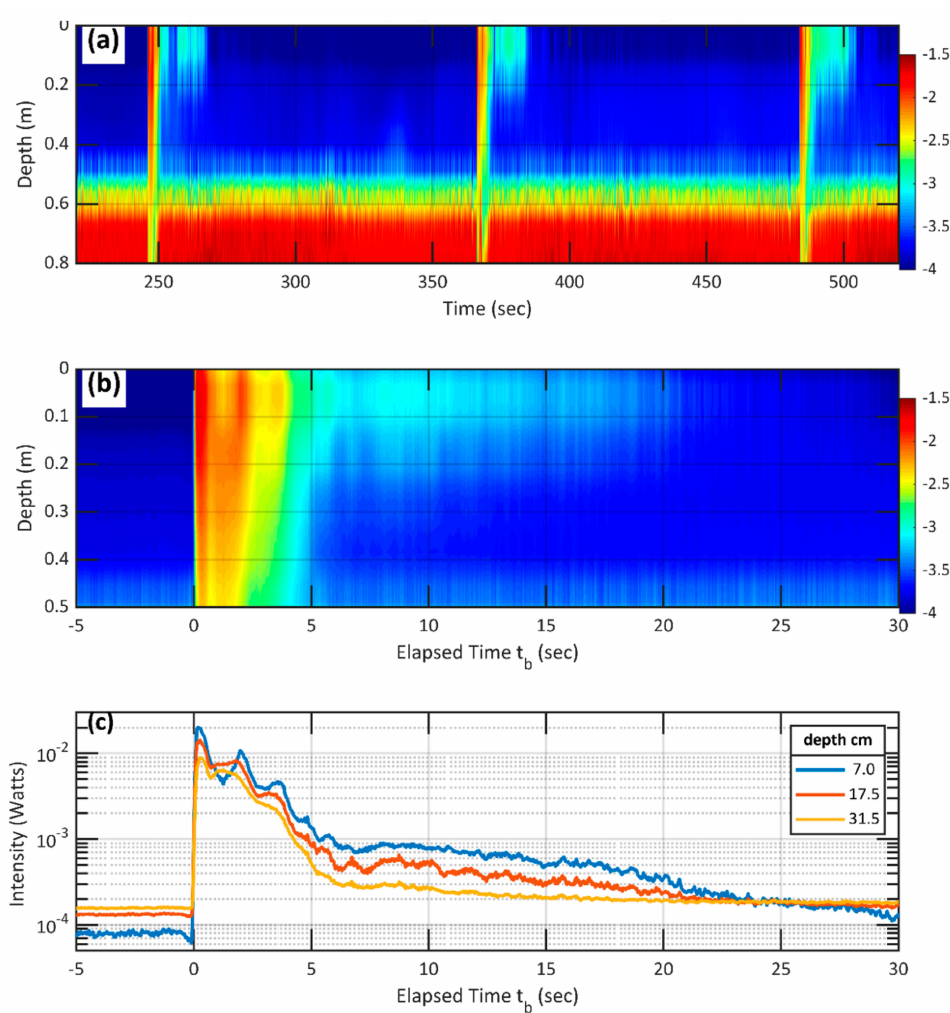
Figure 3. ( a ) Samples of subsurface profile measurements of LiDAR backscatter intensity (Watts) during three repeated breaking-wave generations. ( b ) Ensemble-averaged LiDAR backscatter vertical profiles. Colorized backscatter intensity (Watts) is on a logarithmic scale of base 10. ( c ) Time series of ensemble-averaged LiDAR backscatter intensity at depths of 7 cm, 17.5 cm, and 31.5